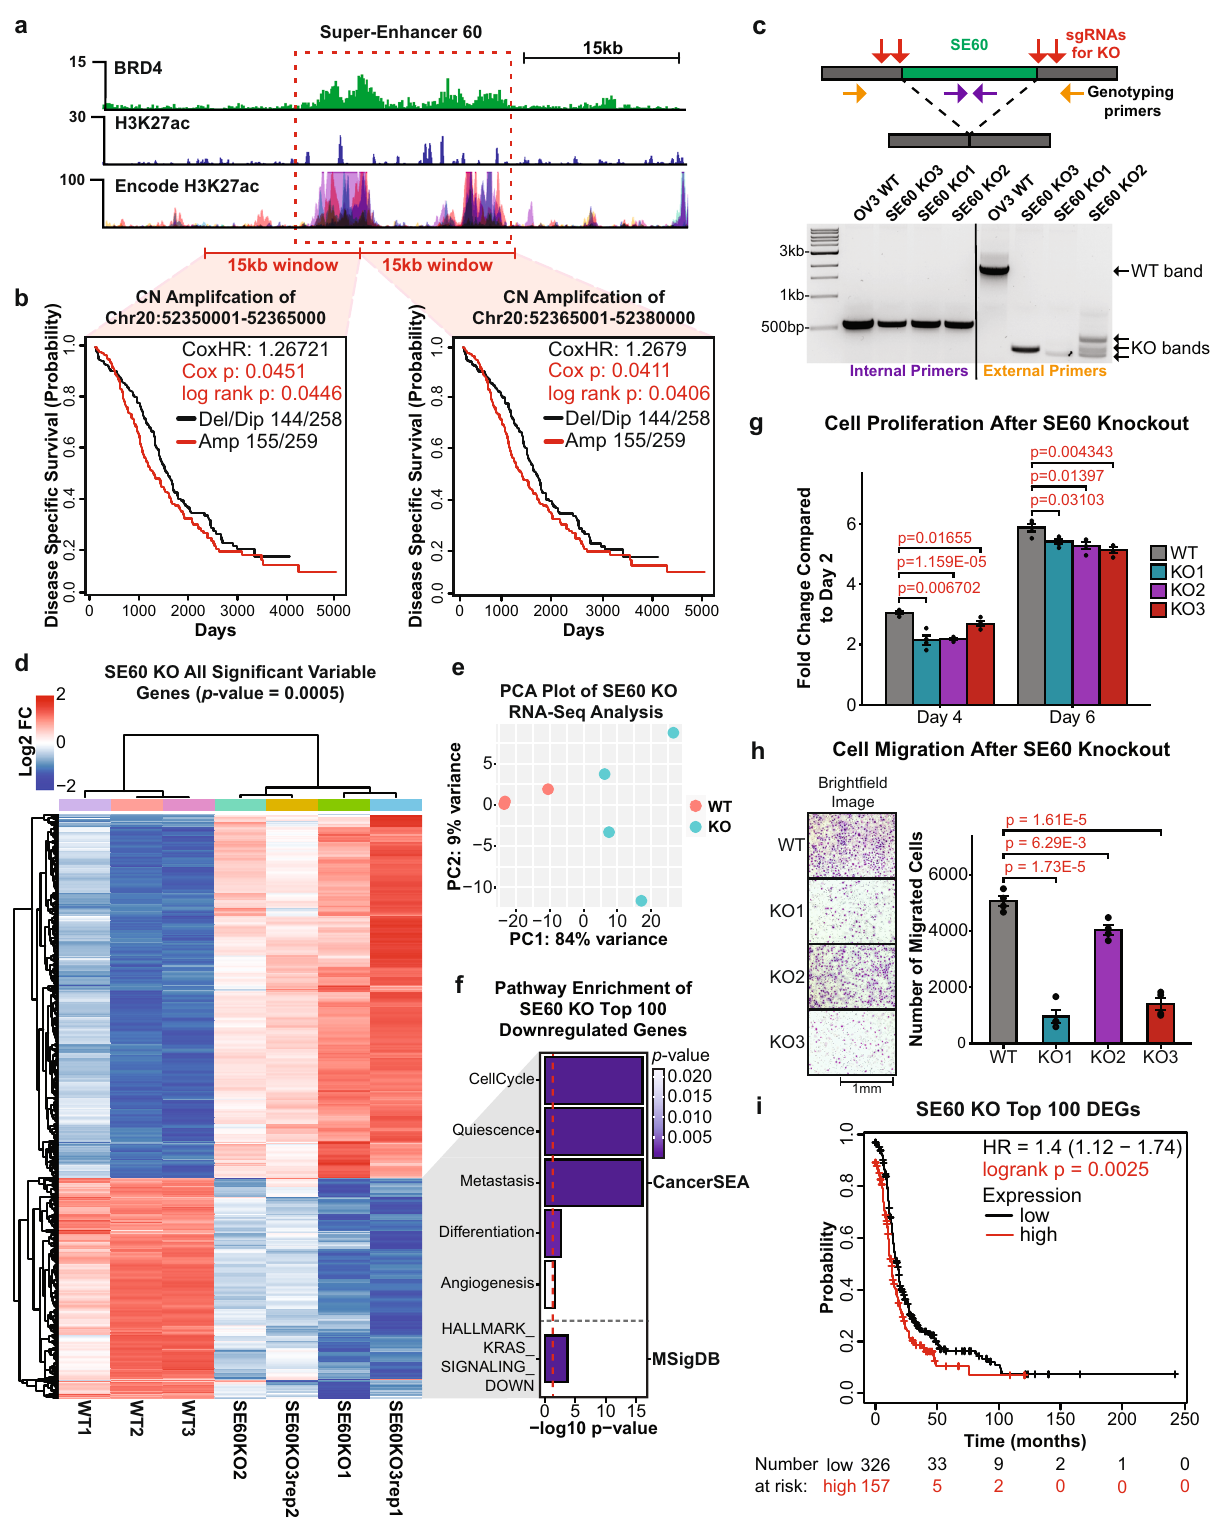
Fig. 6, and Supplementary Data 10). The notion that SE60 plays a key role in ovarian cancer was further validated by the effects that deletion of this SE had on cancer cell proliferation and migration (Fig. 4g,